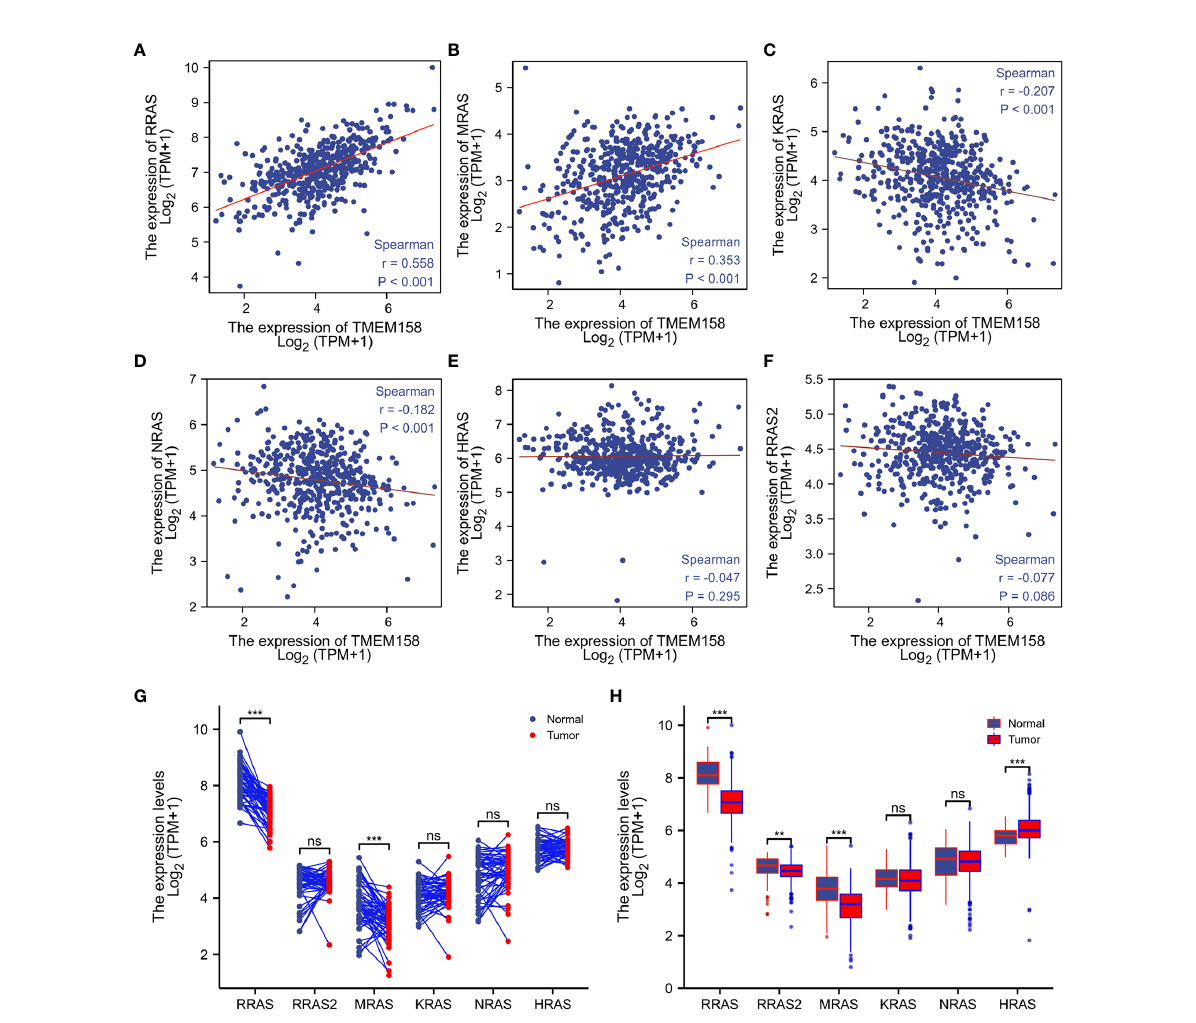
FIGURE 6 TMEM158 expression is correlated with R-Ras subfamily genes. (A – F) Spearman correlation analysis was conducted using the TCGA-PRAD RNA- seq dataset between TMEM158 and Ras family genes. Spearman r > +/- 0.3 was considered as a strong correlation. (G, H) Gene expression levels of Ras family genes were extracted from the TCGA-PRAD RNA-seq dataset. Two types of comparison were conducted, case-matched pairwise (G) and group cohort comparison. The asterisk indicates a signi fi cant difference compared to the normal group (**p < 0.01, ***p < 0.001). ns, no signi fi